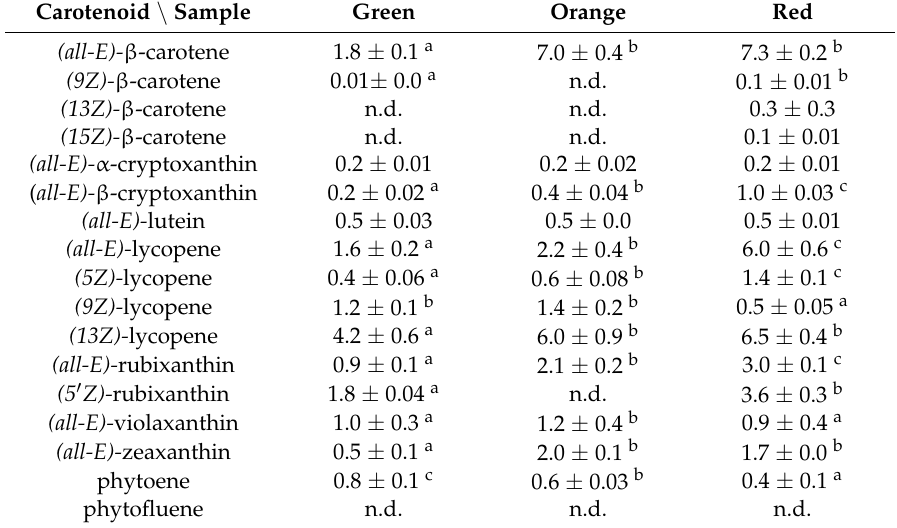
Table 1. Concentrations of carotenoids (mg/100 g) in saponified extracts of R. rugosa at different ripening